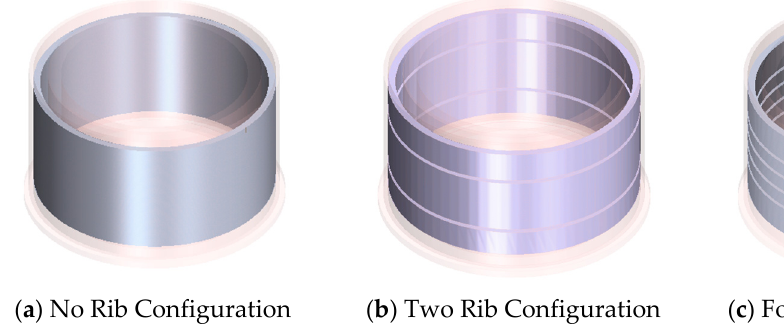
Figure 4. Boundary Definition of E-Machine.